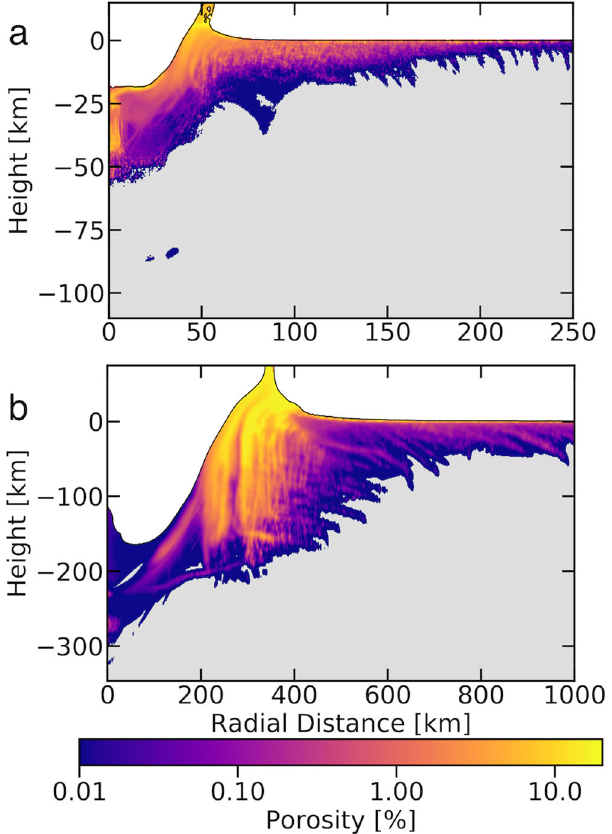
Fig.2|Porosityresultsfor10and100kmdiameterimpactors.a Plotofporosity 150safterinitialcontactofa10kmdiameterimpactorwithpristinelunarsurfaceat 15km/s. b Porosity values in an initially intact lunar surface 500s after a 100km diameterimpactorstruckthesurfaceat15km/s.Thematerialthatnowhasporosity is colored according to the log color bar on the right. All gray colored material is pristine, meaning it has no porosity. Note both ( a ) and ( b ) are vertically exag- gerated, with aspect ratios of 1.359 and 1.6 respectively. In frame ( b ) porosity is produced >1000km from the point of impact, but this is outside of our high- resolution zone. The low porosity values found within the crater in frame ( b ) are due to melt